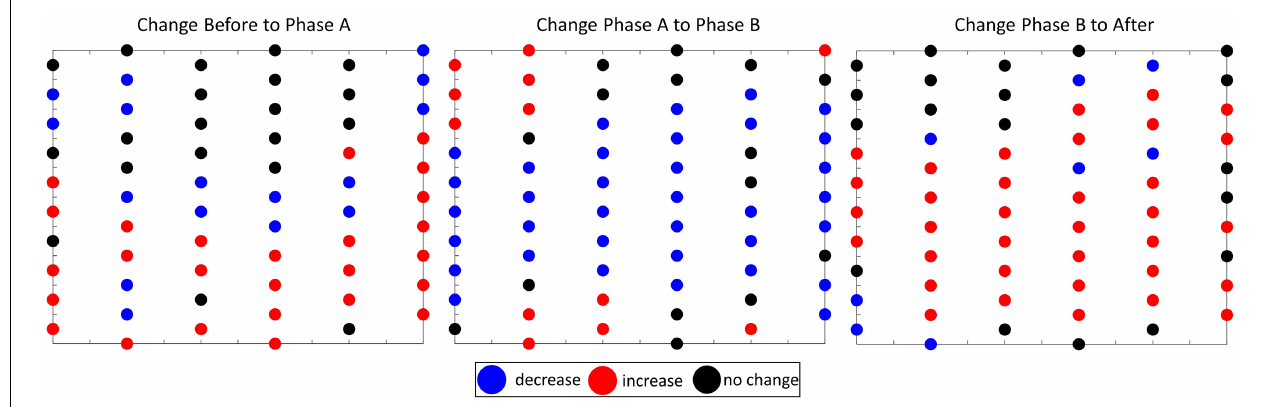
FIGURE 10 | Spatial layout of PMRF hydrophone array, where the circles represent the hydrophones of the array, and the color represents the change in the number of GVP on each hydrophone from one analysis period to the next: blue = decrease, red = increase, black = no change. Left - the change from Before to Phase A, Middle- the change from Phase A to Phase B, and Right - the change from Phase B to